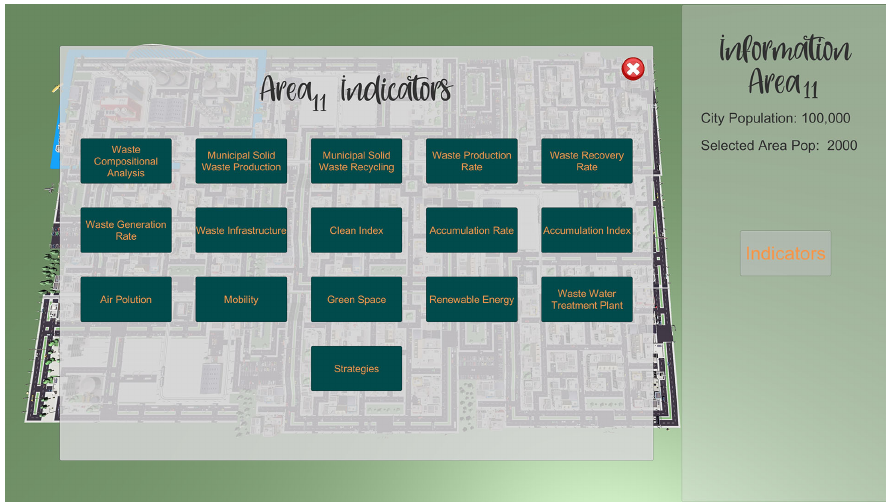
Figure 8. Key performance indicators for each region are shown on a dashboard to provide a high-level, easily interperable overview of waste management performance.